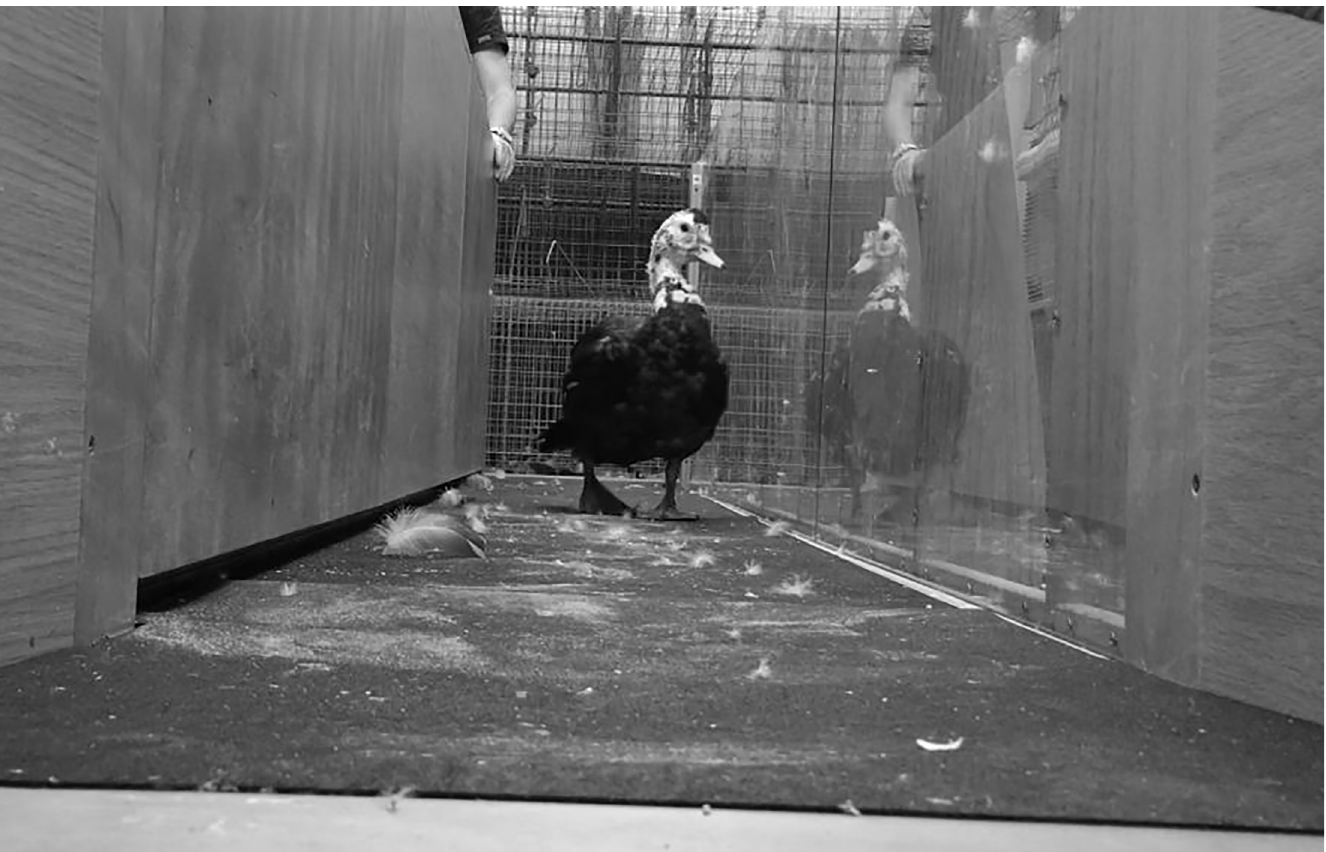
Fig 1. Pressure sensitive walkway. Muscovy duck ( Cairina moschata domestica) on pressure sensitive walkway (PSW) within a custom-designed chute composed of wooden and acrylic panels.